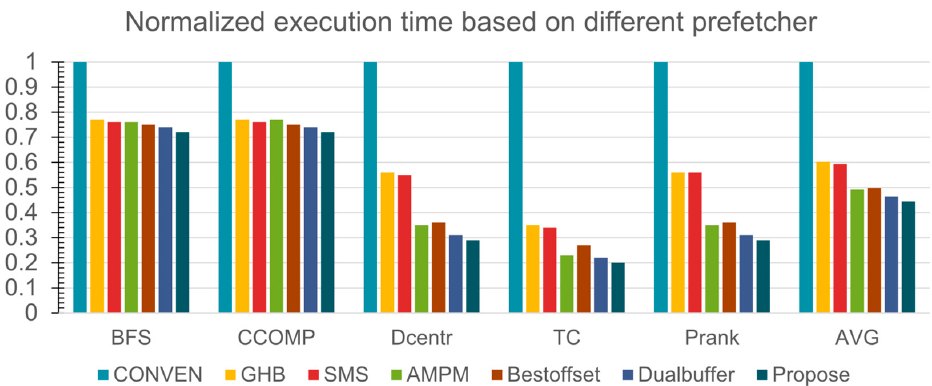
Figure 11. Execution time for graph processing.